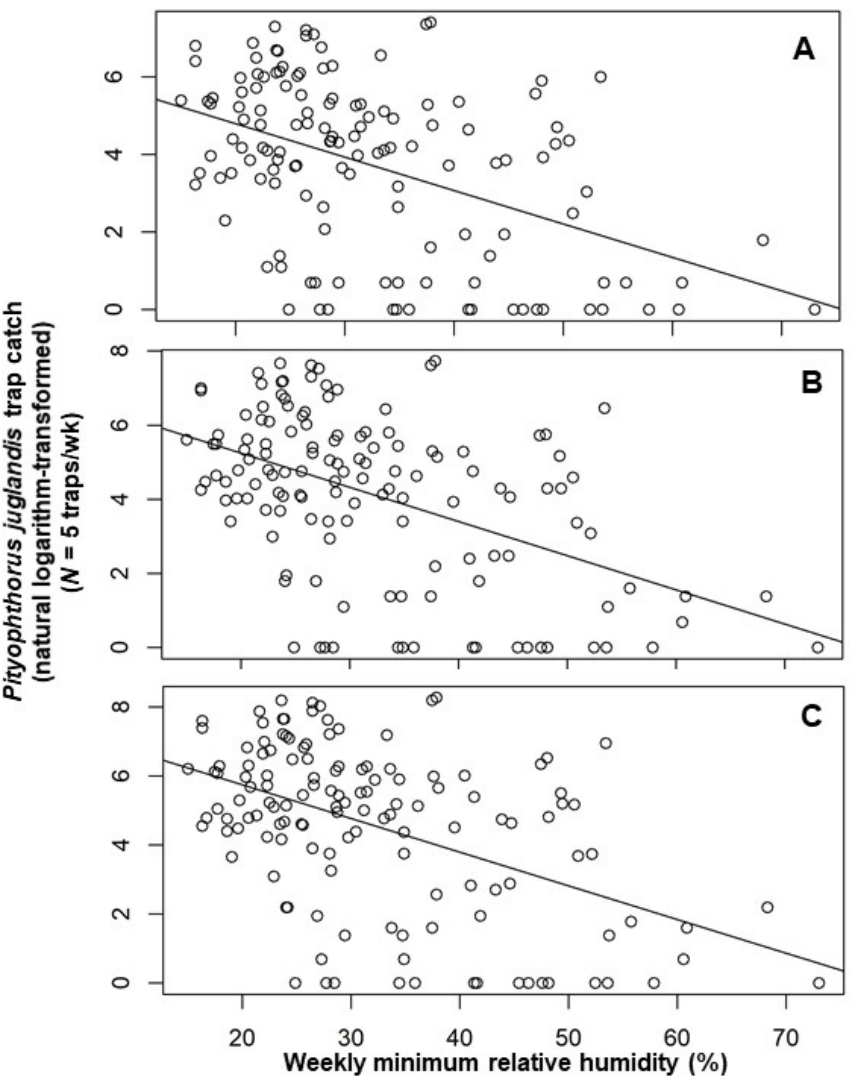
Figure 3. Scatter plot of weekly catches of Pityophthorus juglandis per trap (natural logarithm-transformed) against weekly average minimum relative humidity (%). ( A ) Male; ( B ) Female; and ( C ) Total. The straight line is the linear regression fitted by ordinary least square. Pityophthorus juglandis was collected weekly from 29 August, 2011 to 2 June, 2014 in a native riparian forest stand of northern California black walnut, Juglans hindsii ; Fremont’s cottonwood, Populus fremontii ; and valley oak, Quercus lobata , located along the north fork of Putah Creek in Davis in Yolo Co., California, USA. Utilization of a forward selection method resulted in multiple regression models with the same two temporal variables, but also terms for total solar radiation, average vapor pressure, maximum air temperature, average minimum air relative humidity, and average soil temperature. However, we found that average weekly air temperature was highly and positively correlated with total solar radiation ( r = 0.88), average vapor pressure ( r = 0.76), maximum air temperature ( r = 0.96), and average soil temperature ( r = 0.96). Thus, for simplicity, we do not further report on these